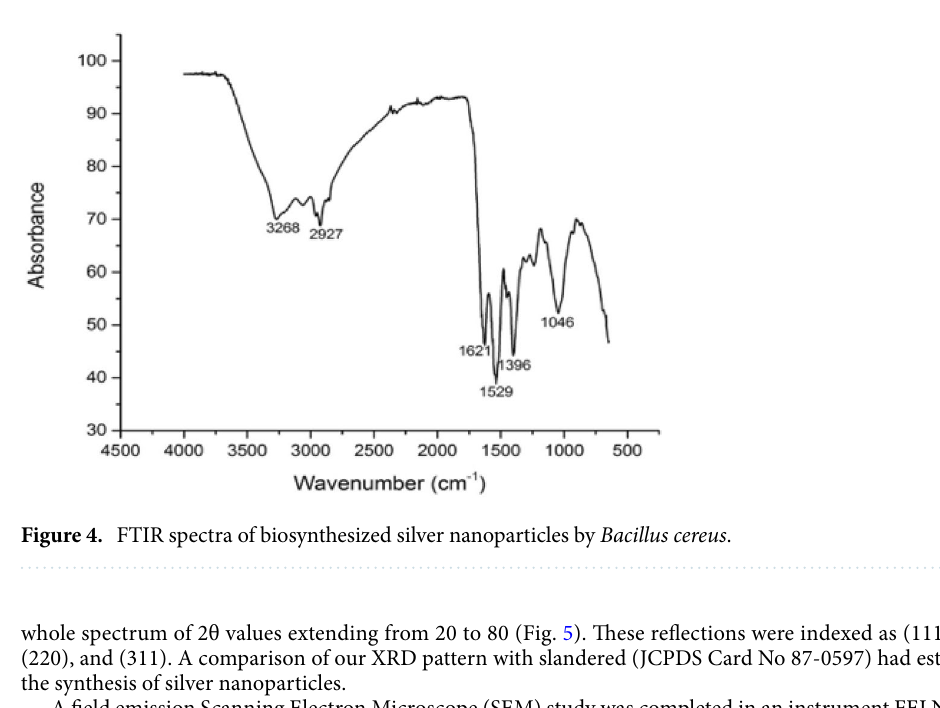
Figure 3. Particle size distribution of biosynthesized silver nanoparticles.